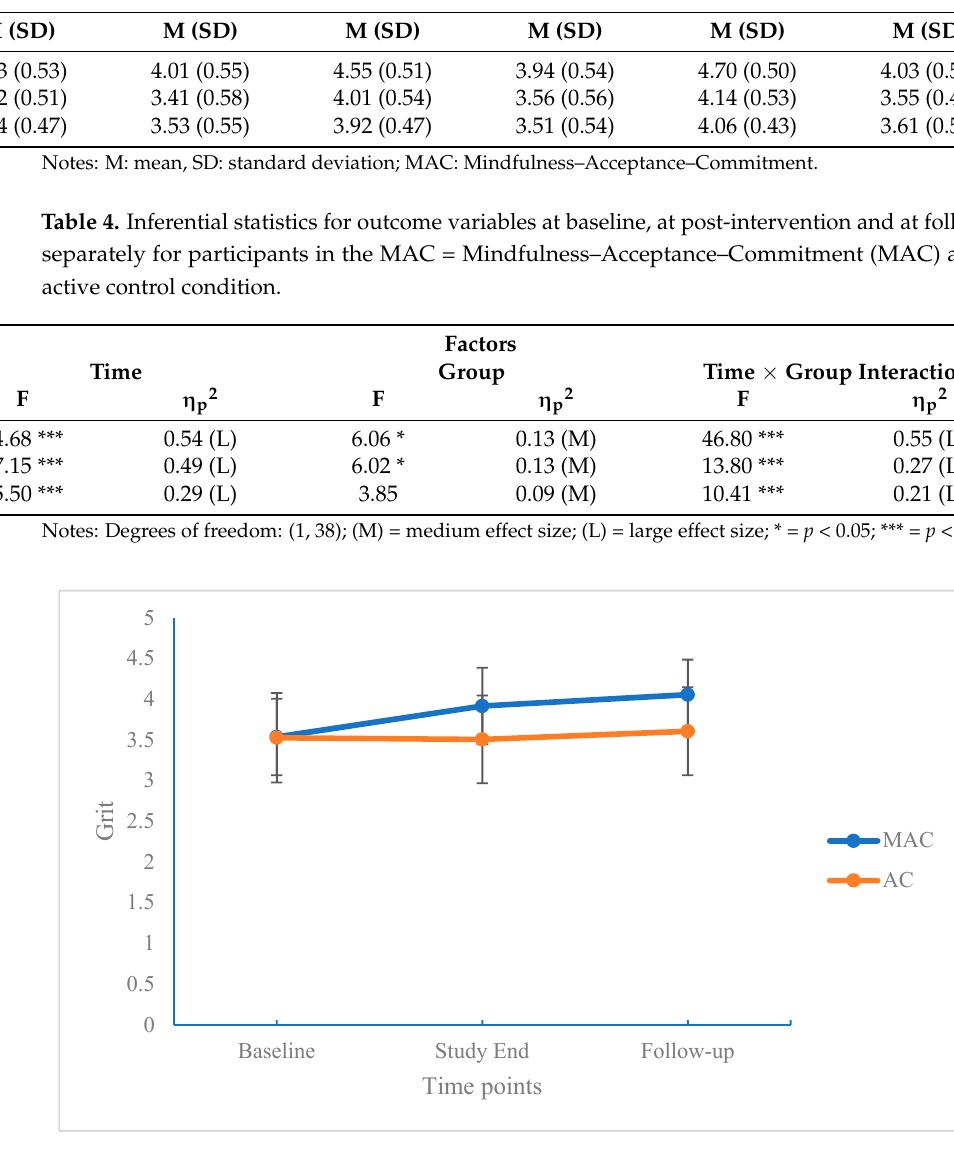
Figure 2. Grit increased over time, but more so in the MAC condition compared to the active control condition. Improvements at the end of the study remained stable until follow-up 4 weeks later. Points are means and bars are standard deviations.